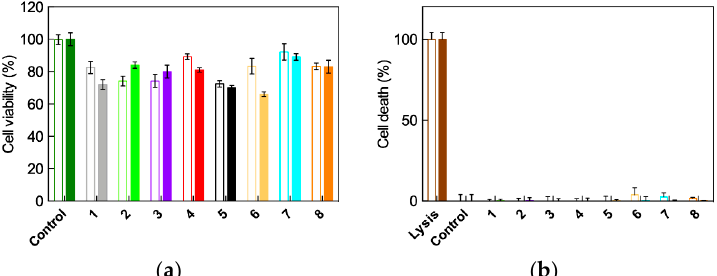
Figure 6. Metabolite toxicity ( a ) and membrane damaging activity ( b ) of self- and non-self-assembling dendrons 1 – 8 and their complexes with a scrambled (i.e., non-silencing) siRNA sequence (50 nM siRNA, N/P = 10) in PC-3 cells using the 3-(4,5-dimethylthiazol-2-yl)-2,5-diphenyl tetrazolium bromide (MTT) assay and the lactate dehydrogenase (LDH) assay, respectively. Untreated cells were used for control. Adapted from [7] with the permission of John Wiley and Sons, 2016.